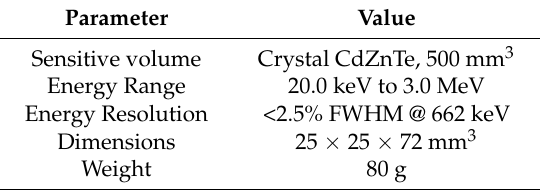
Table 1. CZT characteristics as declared by the manufacturer.